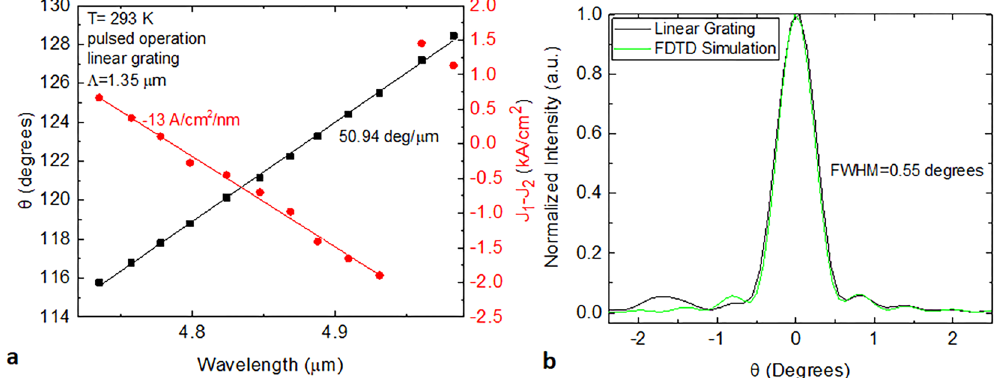
Figure 3. Tuning and steering behaviour for SGDFB lasers with linear grating outcouplers. ( a ) Steering angle and relative current density in the SGDFB sections as a function of emission wavelength. ( b ) Comparison of experimental and simulated far-field spectra in theta direction.